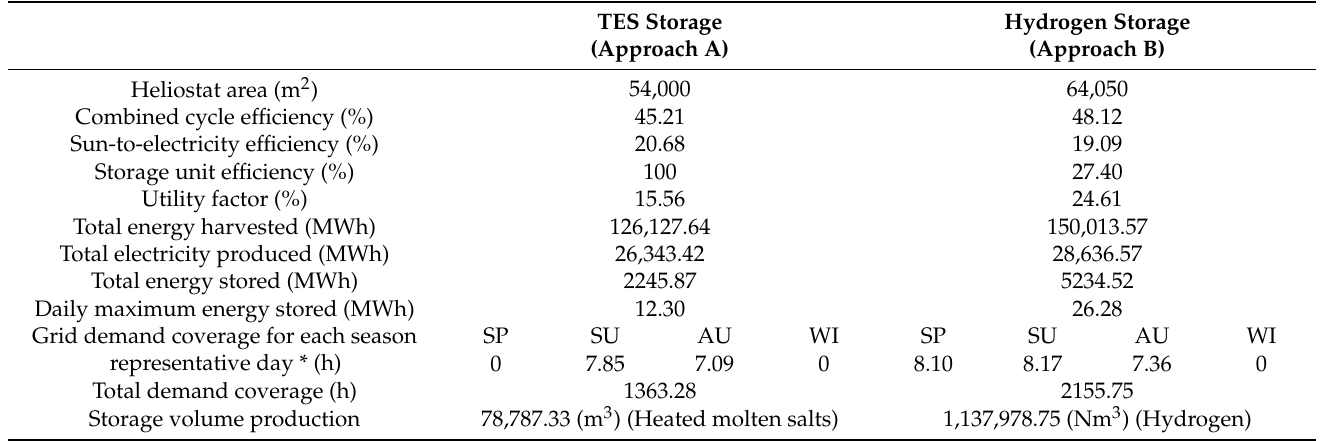
Table 5. Annual performance of both ISCC energy storage